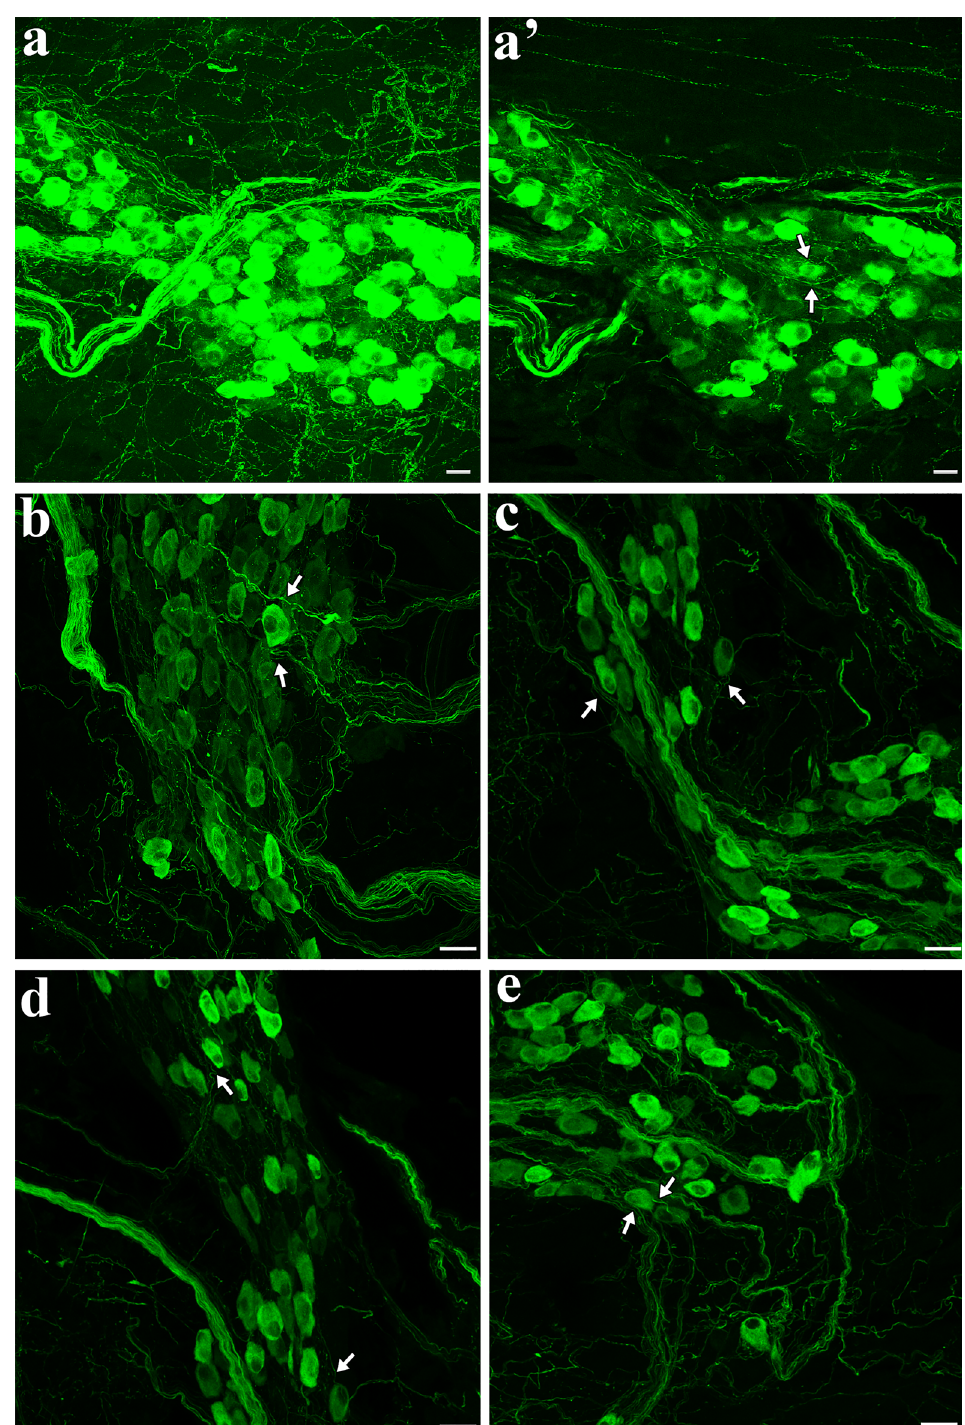
Figure 11. TH-IR axons passed through ICG without apparent innervation. ( a ) Maximal projection image showed TH-IR axons mainly passing through a group of TH-IR neurons. ( a’ ) Single optical section of the corresponding image in ( a ). ( b-e ) Partial projection image of different ICG represented the pattern of TH-IR axons passing though rather than directly innervating the TH-IR neurons. Arrows indicate TH-IR axons passing by TH-IR neurons. Zoom 1X ( a,a’ ), Zoom 2X ( b-e ). Scale bar: 20